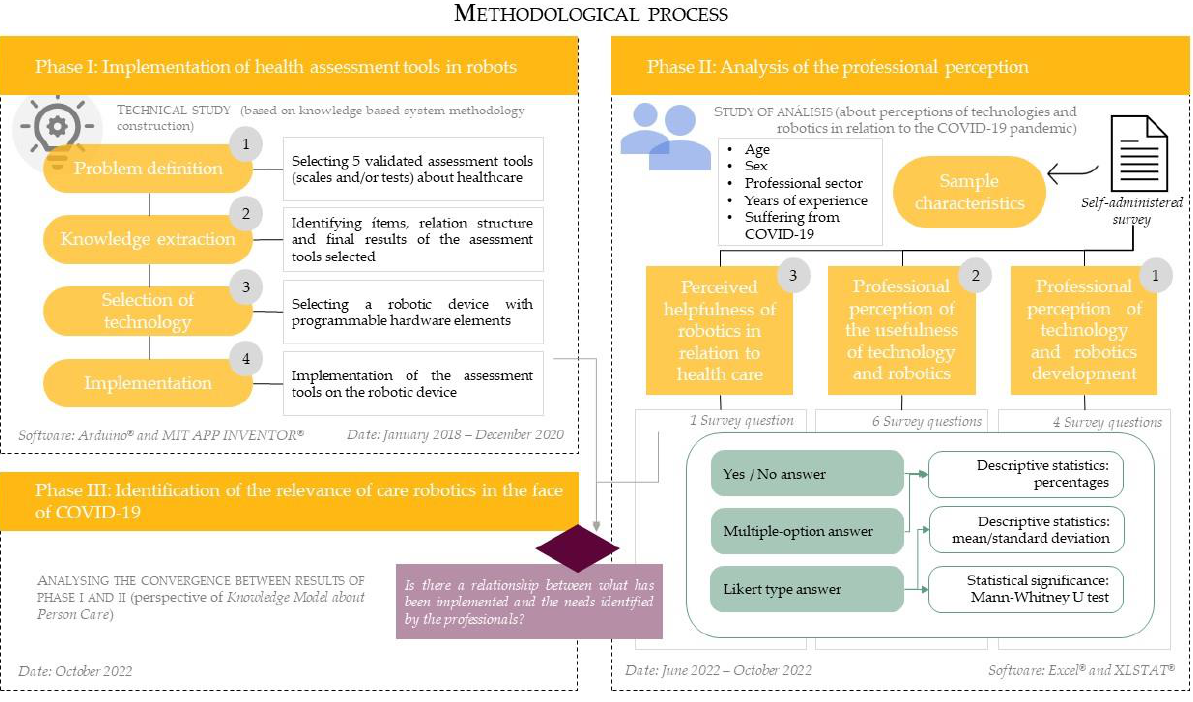
Figure 1. Methodological process scheme.